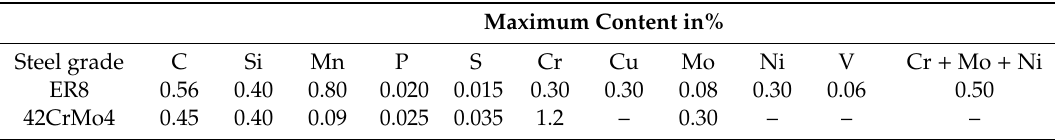
Table 1. Chemical composition of ER8 and 42CrMo4 steels.